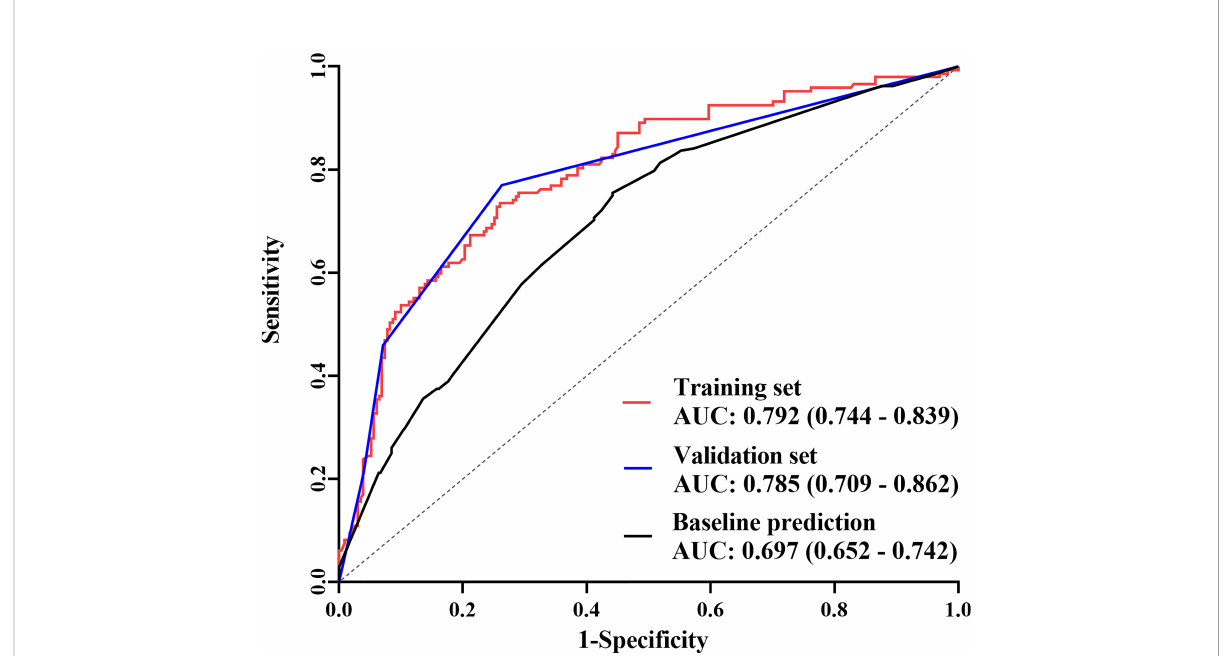
FIGURE 5 The receiver operating characteristic (ROC) curves The area under the curve (AUC) was 0.792 (95% CI: 0.744 – 0.839) in the training set, 0.785 (95% CI: 0.709 – 0.862) in the validation set, and 0.697 (95% CI: 0.652 – 0.742) in the predictive model only including baseline